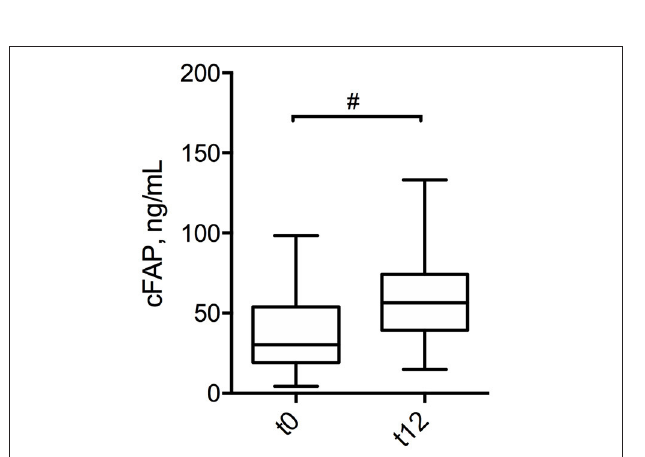
FIGURE 2 | Receiver operating characteristic (ROC) curve for cFAP level’s accuracy to distinguish patients with IBD from HC.